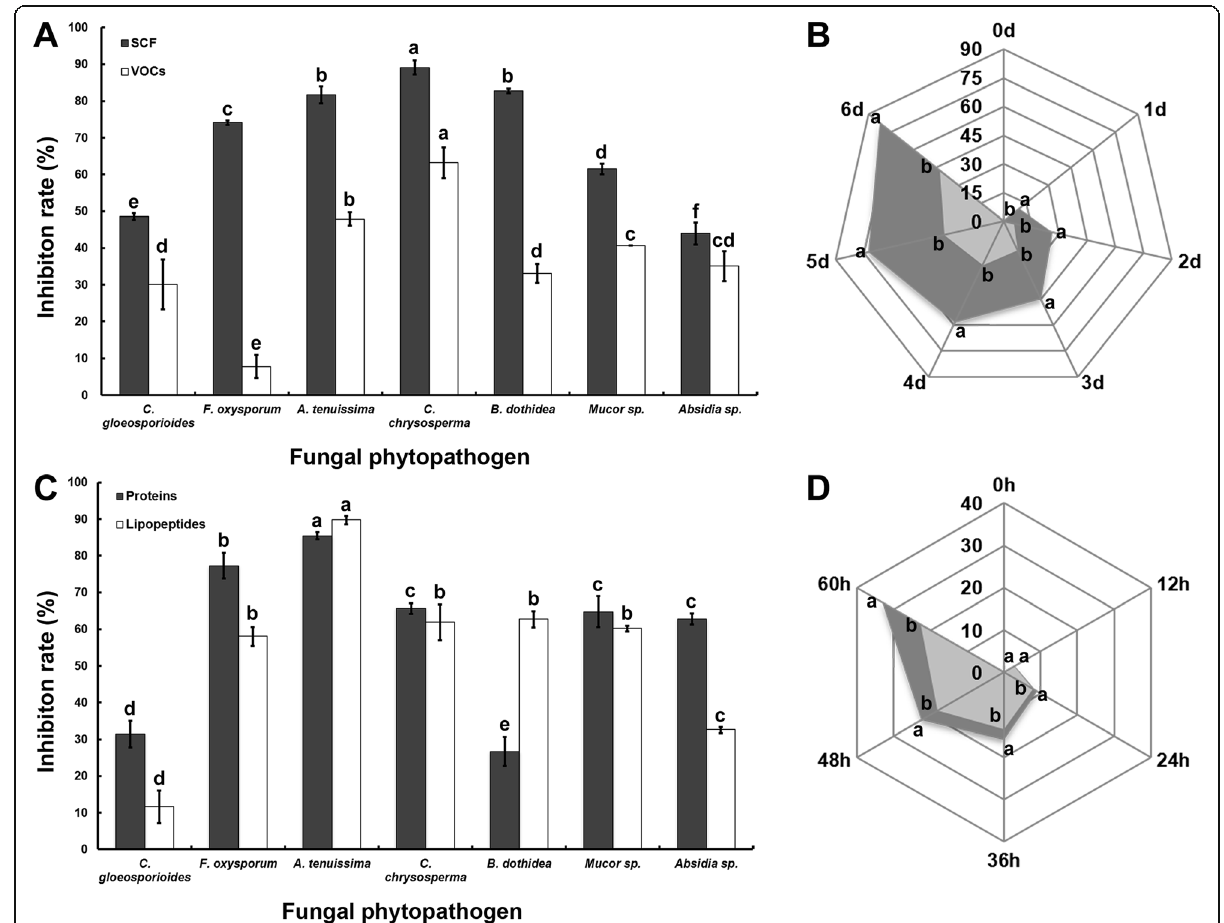
Fig. 2 Antifungal activities of strain ZSH-1 against fungal phytopathogens. a , c Antifungal activities of SCF, VOCs, protein, and lipopeptide extracts from SCF against fungal phytopathogens, Values with the different letter within the same color shaded box are significantly different at the p pro.2004.03.014vity of the test. b , d Inhibition patterns as determined by colony diameter of C . gloeosporioides by the SCF ( b ) and VOCs ( d ) (inner shaded area) compared to each control (outer shaded area). The unit for all axes in the chart is millimeters. Different letters within the same axis in the spider chart are significantly different each other at the p ≤ 0.05 level of the t